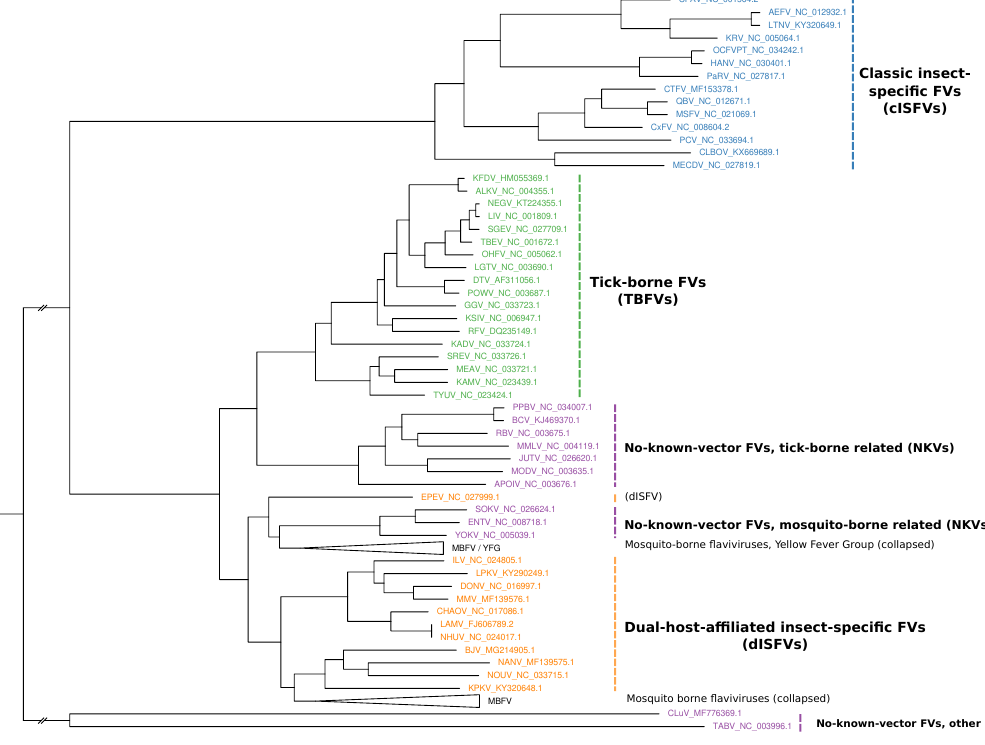
Figure 1. Maximum-likelihood phylogenetic tree of the genus Flavivirus , highlighting the major groups ISFVs (blue), dISFVs(orange), TBFVs (green), and NKVs (magenta). The MBFV Yellow Fever virus group (YFG) and the main MBFV branch were not covered in this study and are both collapsed. The tree has been computed from a MAFFT alignment of complete polyprotein amino acid sequences with iq-tree . Figure rendered with FigTree